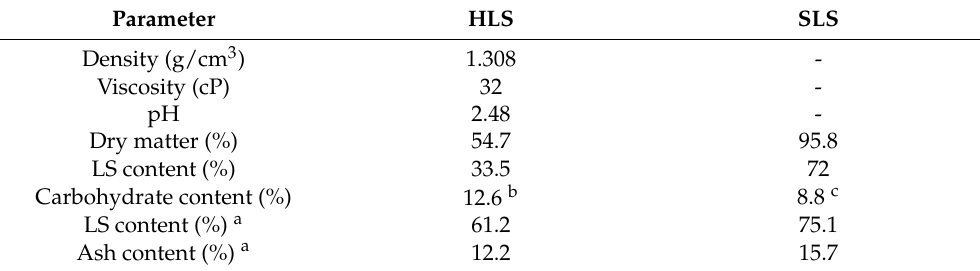
Table 1. Physico-chemical characterization results of the HLS and SLS samples.